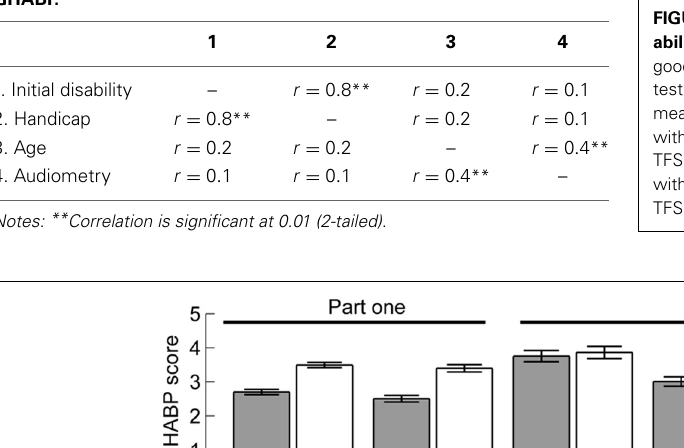
Frontiers in Neuroscience | Auditory Cognitive